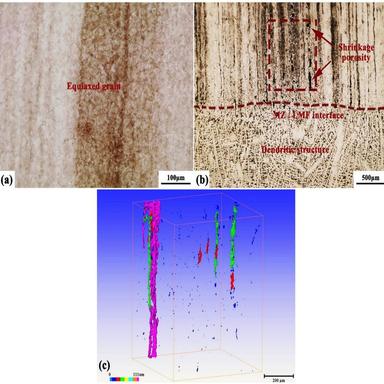
The enlarged views of the featured areas in electrode tip, (a) Electrode matrix, (b) MZ and LMF, (c) 3D characterization of the shrinkage porosity in MZ, respectively.